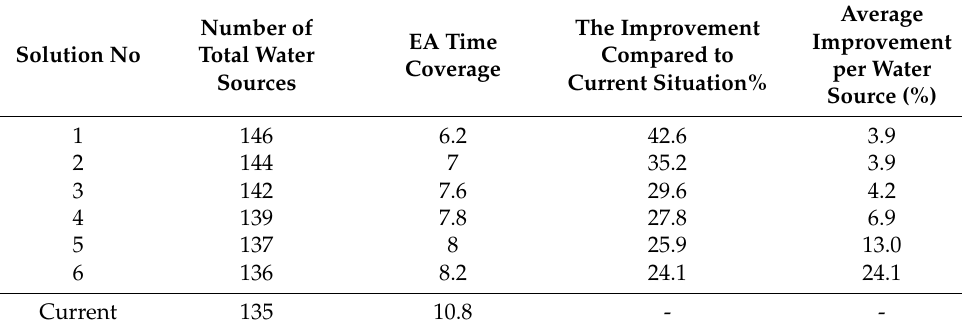
Table 3. Improvements in the Pareto optimal results (water sources).